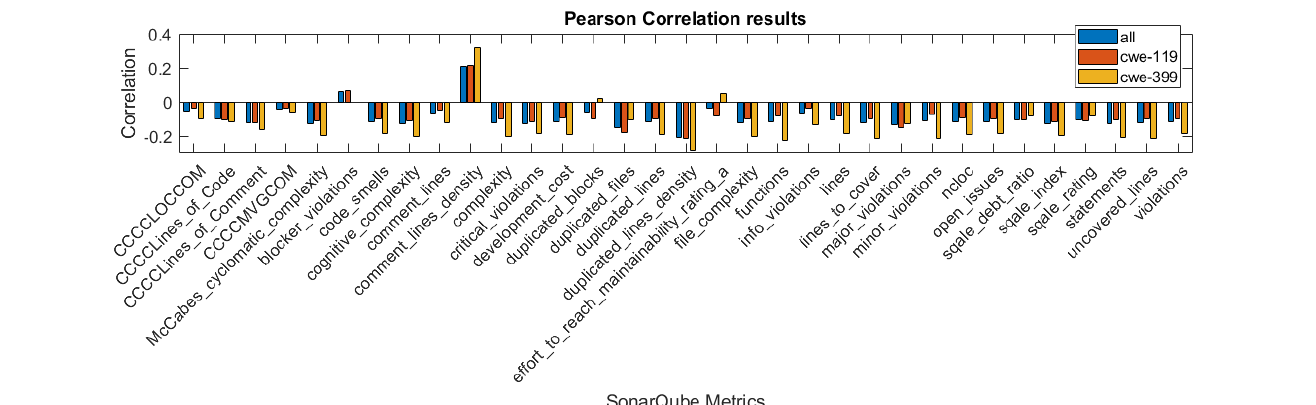
Figure 1. Pearson correlation values for the features obtained using different subsets of a